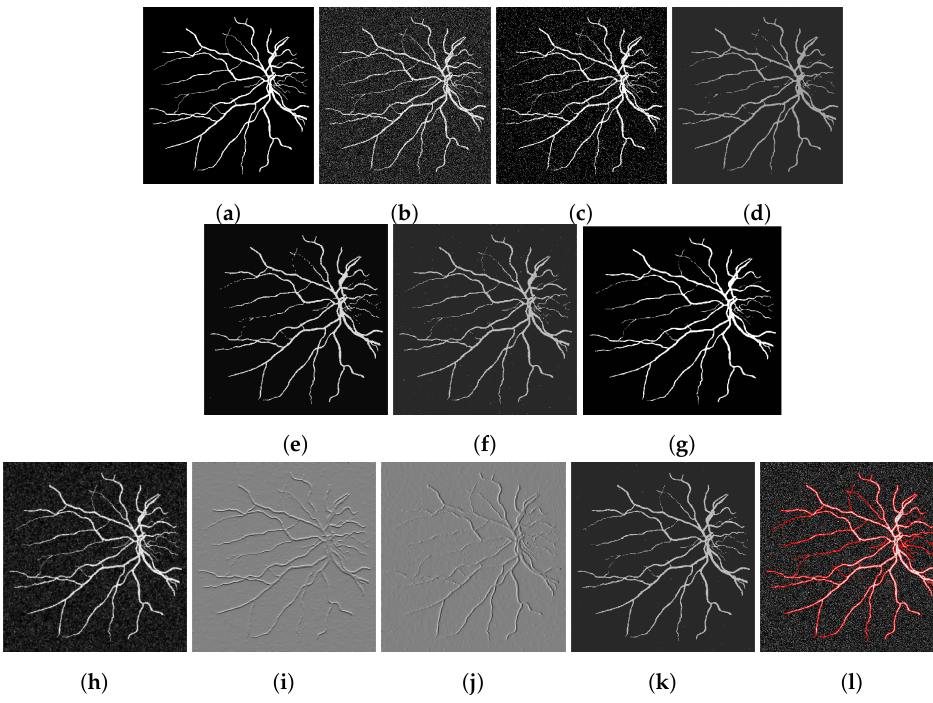
Figure 8. ( a ) Clean image. ( b ) Noisy image used as input to the models. ( c ) Output of the CRCV model. ( d ) CCZ after thresholding. ( e ) CNC after thresholding. ( f ) T-ROF after thresholding. ( g ) DL output. ( h ) Output g of our model. ( i ) Output G x of our model. ( j ) Output G y of our model. ( k ) Ours after thresholding. ( l ) Our